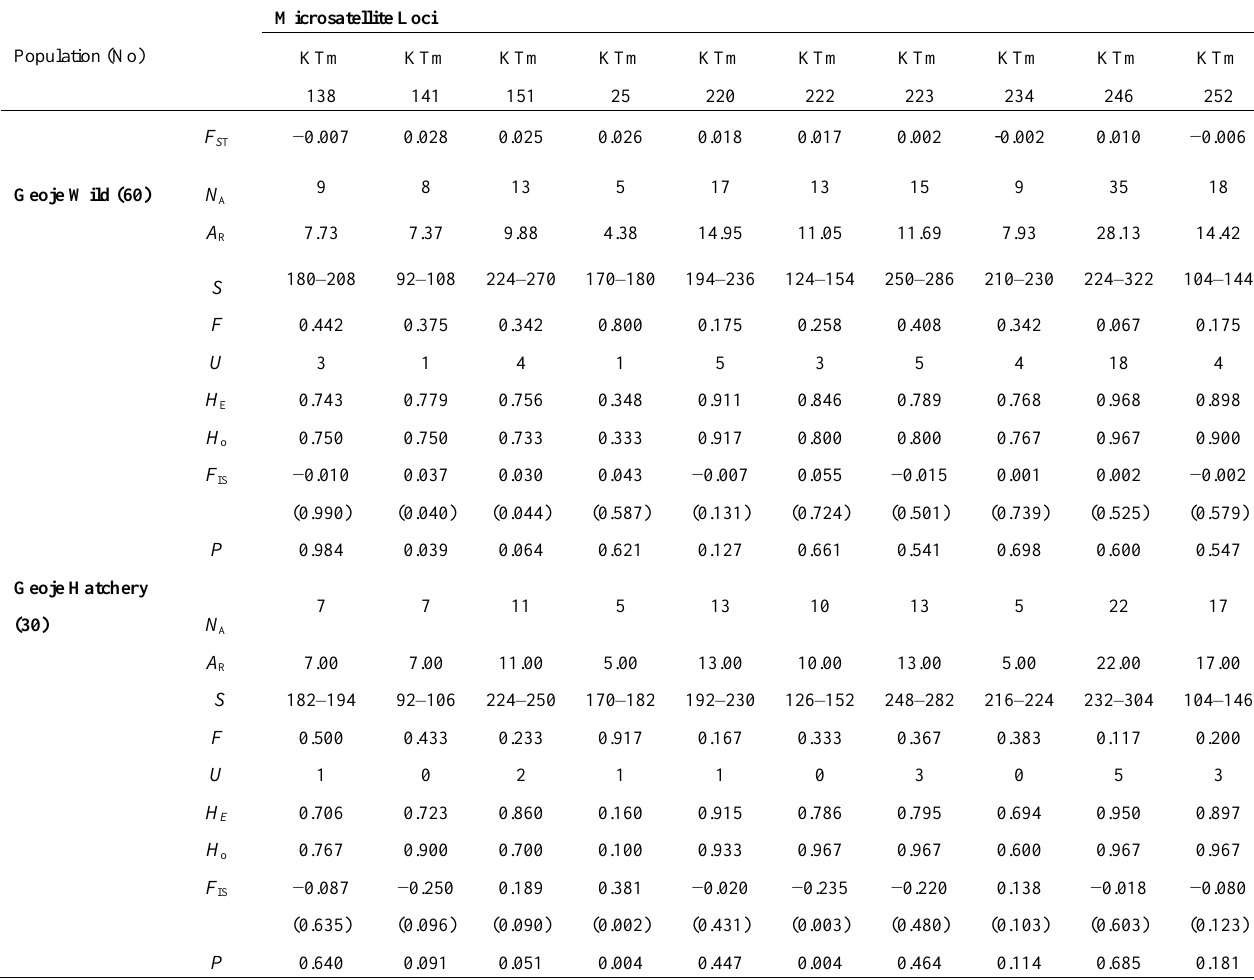
Table 2. Summary of the statistics for the 20 microsatellite loci in the two Thamnaconus modestus